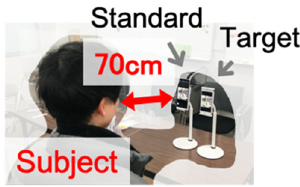
Figure 13. Experimental condition.